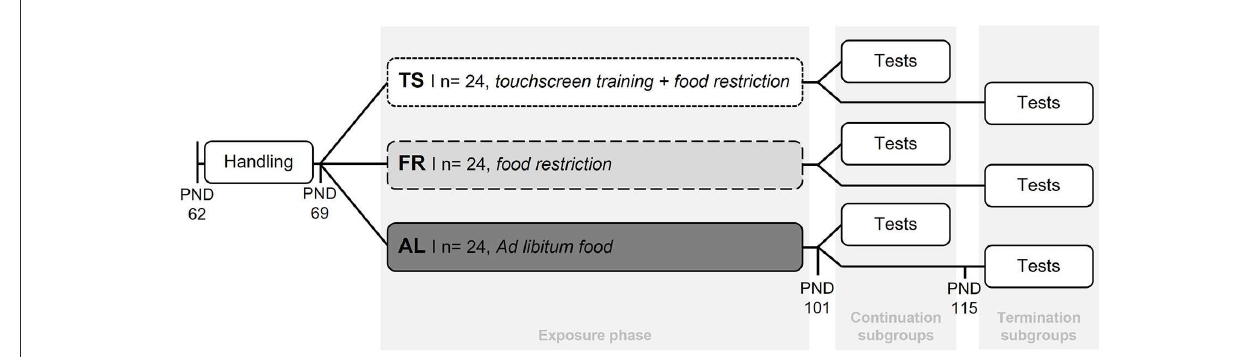
FIGURE1 Experimental design. After the mice were habituated to tunnel handling (PND 62–69) they were assigned to one of three groups. TS, touchscreen trained and mildly food restricted (90–95% of ad libitum feeding weights) group; FR, food restricted group (90–95% of ad libitum feeding weights) without touchscreen training; AL, ad libitum fed group without touchscreen training. After the 5-week long exposure phase, half of the mice from each group were tested in behavior tests, while their feeding routines and touchscreen training remained unaffected. These subgroups were termed “continuation subgroups”. For the remaining mice from the TS group the touchscreen training was terminated at this point (PND 101). These mice, as well as the remaining mice from the AL and FR group, were tested in behavior tests 2 weeks later (start: PND 115) and termed “termination